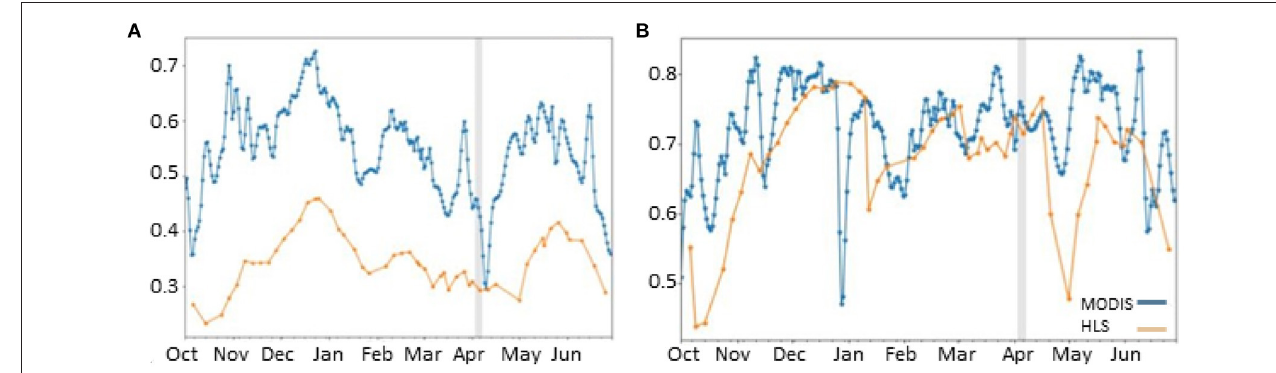
FIGURE 5 | Time series of NDVI from MODIS and averaged HLS at site #1700 (A) and site #1321 (B) . The vertical grey line indicates the date the band was